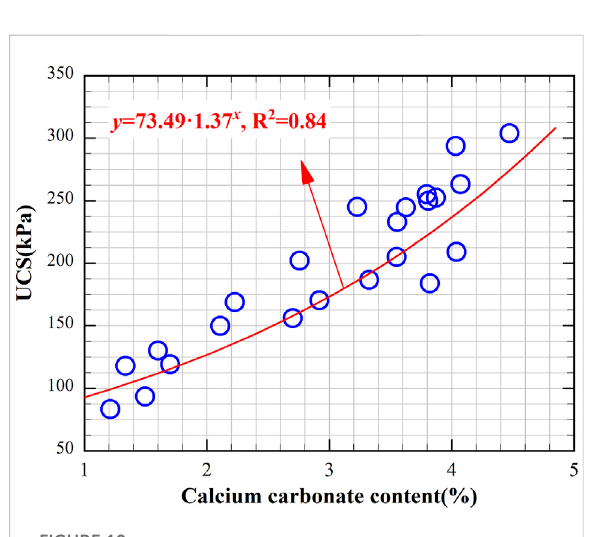
FIGURE 10 Relationship between calcium carbonate content and